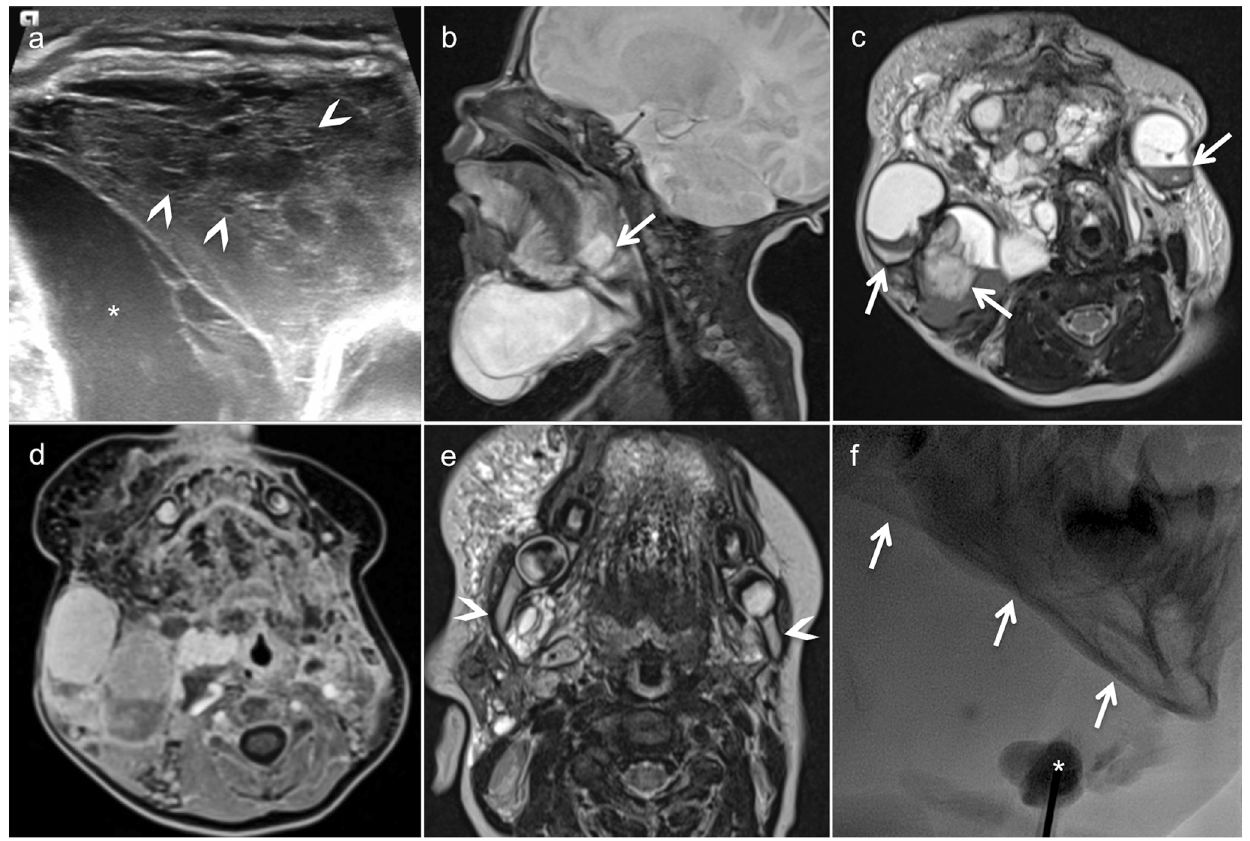
Fig. 12 Lymphatic malformation (LM) in a term-born-boy presenting with a large anterior and lateral neck mass beneath a bluish-coloured skin. a Ultrasound of the neck shows that the mass is composed of large fluid- filled macrocystic ( asterisk ) and microcystic ( arrowheads ) portions. b Sagittal T2 illustrates the macrocystic submental component extending into the base of the tongue ( arrow ). Percutaneous sclerotherapy was car- ried out. Post-sclerotherapy follow-up MRI ( c , d ). c Axial T2 depicts